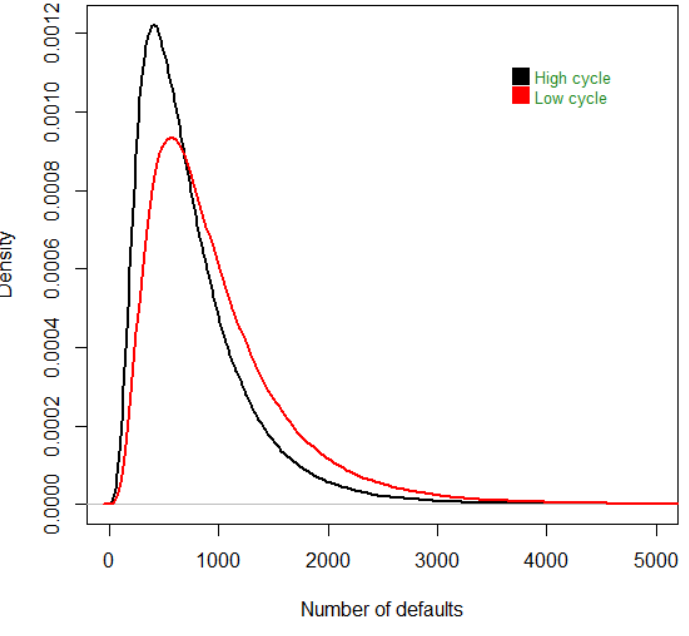
Figure 1. Approximations of default